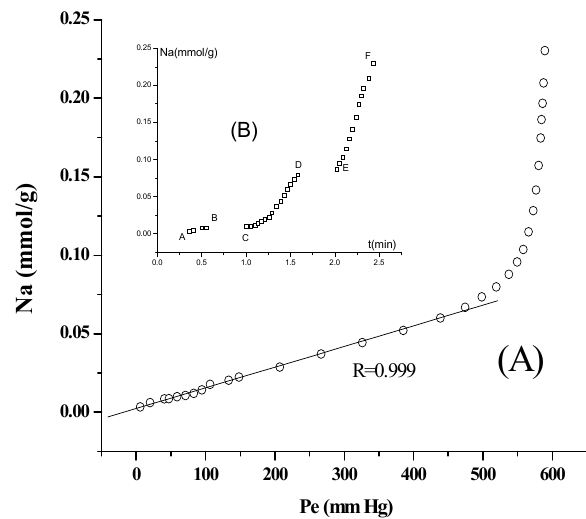
0 100 200 300 400 500